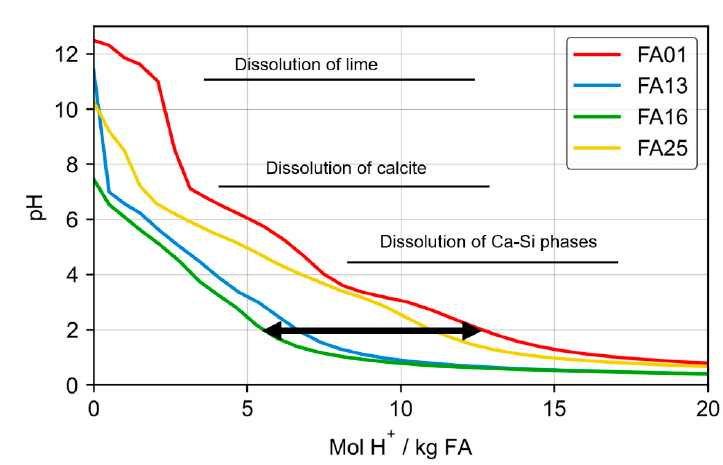
Figure 3. Titration curve of selected FA samples (LS 10). The main plateaus are marked with a black line. The black arrow illustrates the big difference of acid that is required to achieve pH 2.